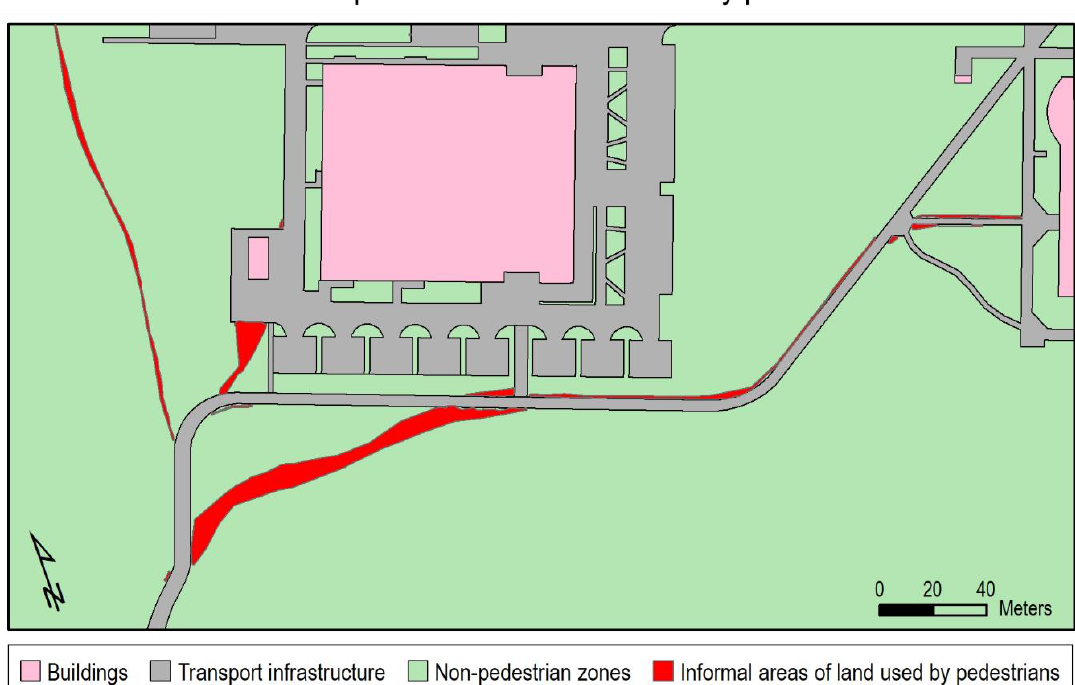
Figure 8. The map of informal areas of land used by pedestrians: the chorochromatic method (qualitative (qualitative data).